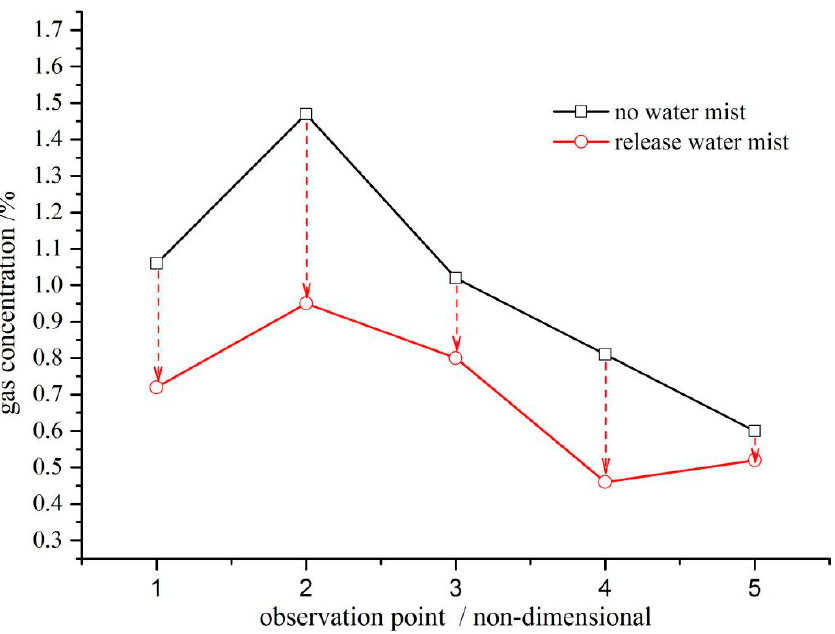
Figure 15. The variations in the gas concentration distribution after the application of water mist in the upper-corner .